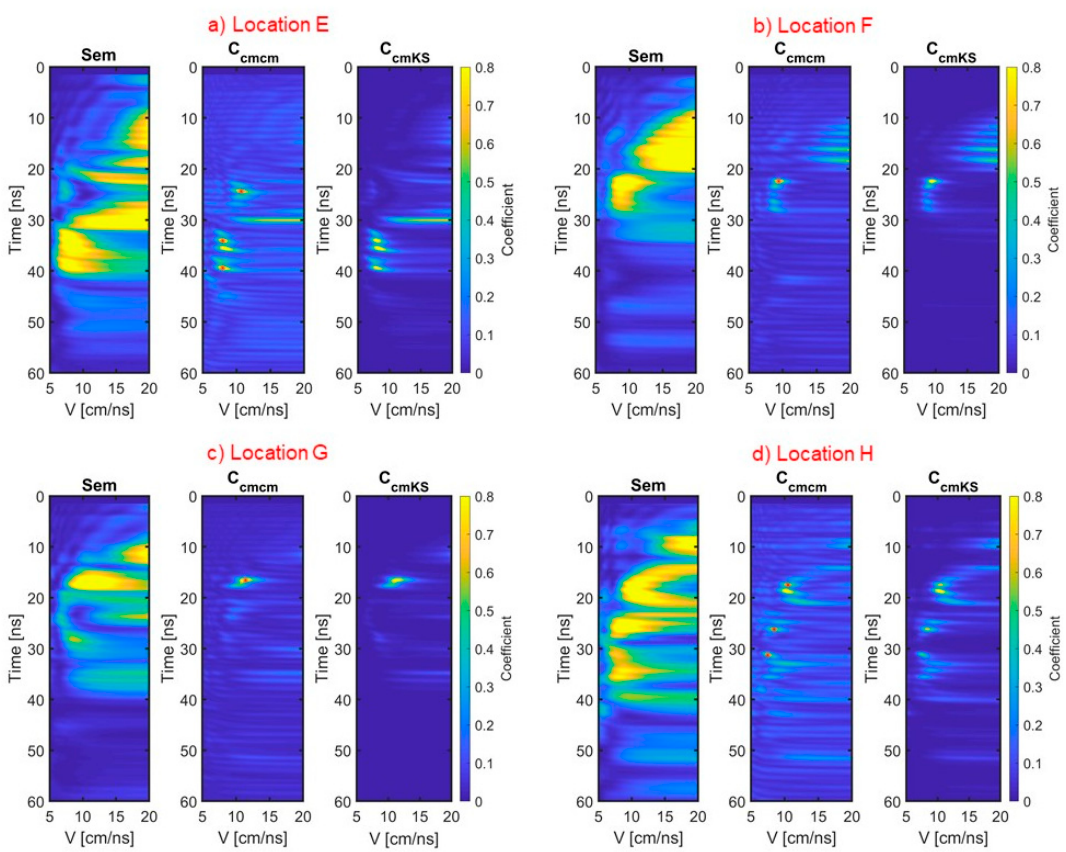
Figure 7. Coherency maps of the Semblance ( Cs ), Complex Matched Coherency Measure ( Ccmcm ) and CcmKS functionals computed in locations E and F of Line 74 ( a , b respectively), and G and H of Line 92 ( c , d respectively). The red asterisks indicate the ( t 0 , Vs ) pairs picked and corresponding to the parameters of the hyperbolae shown in Figure 6a,b. The colour scale and gain are identical for all the functionals. Table 2. Parameters used in the velocity analysis on real data by the different functionals.